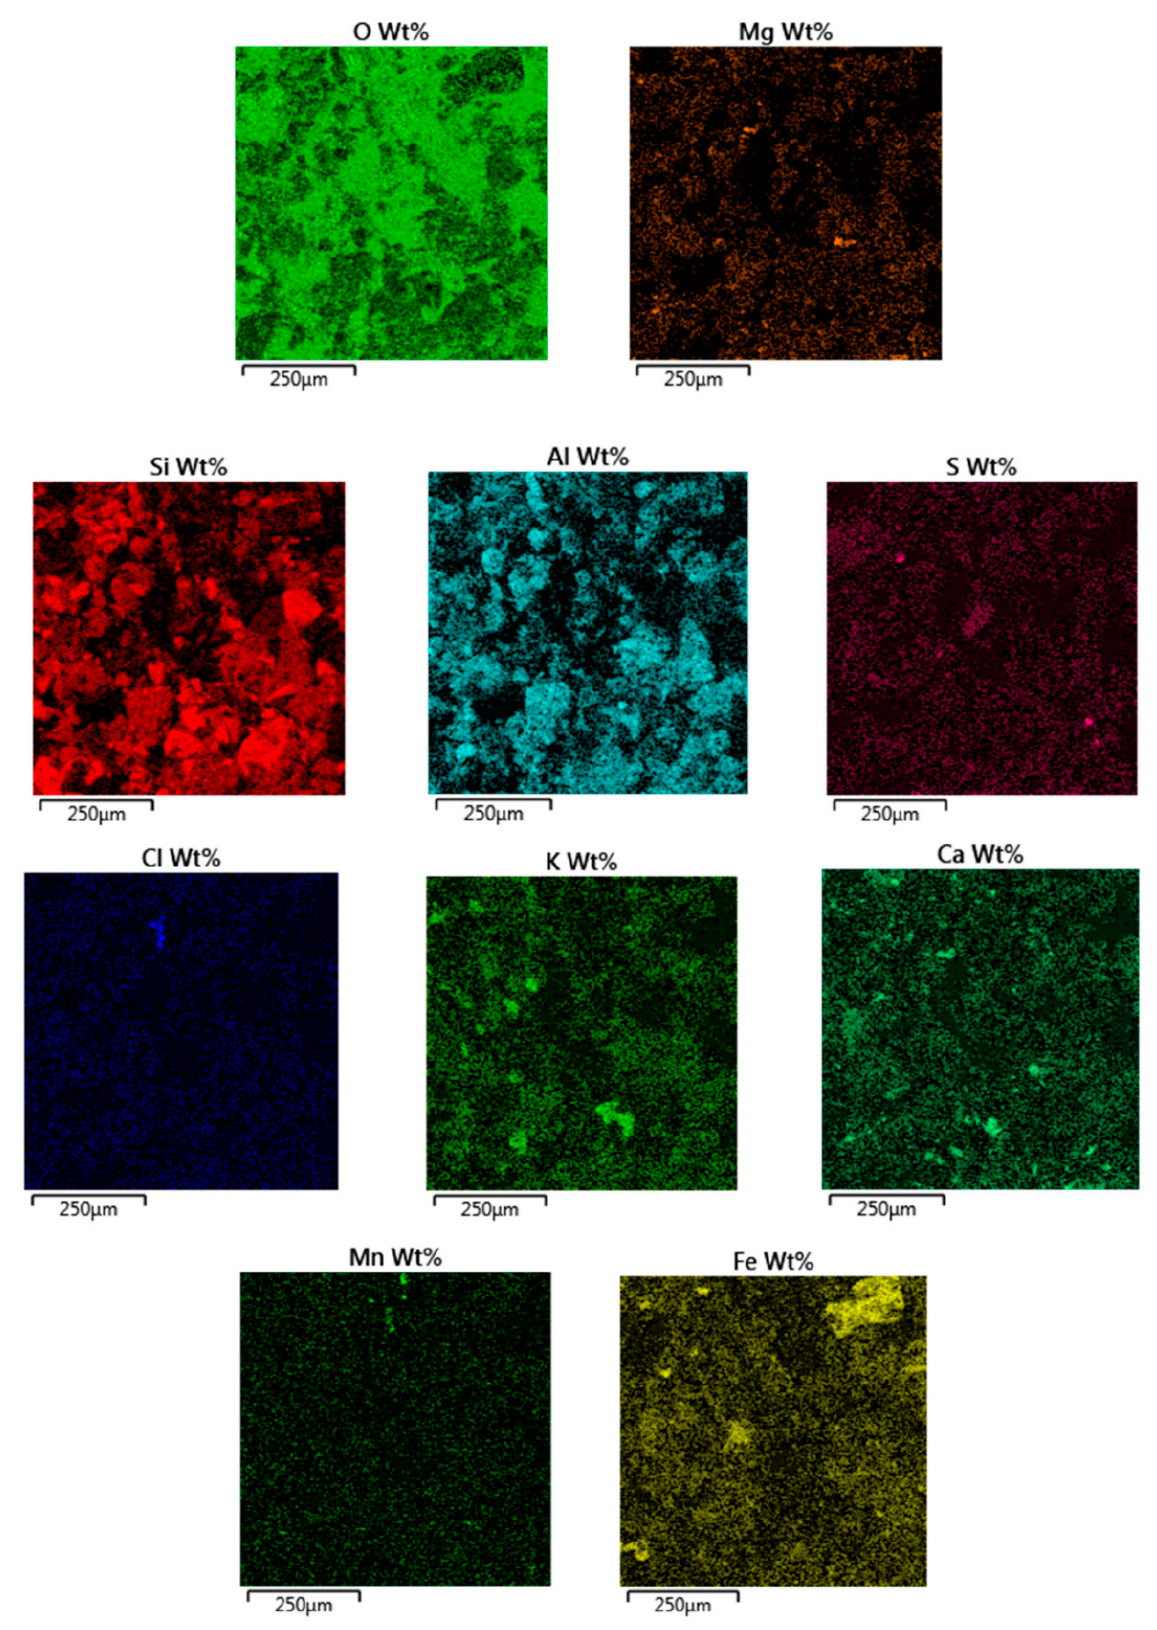
Figure 18. Microanalysis of specimen W2 sediment from Kłodnica river: Elemental content maps over the area given in Figure 17a.